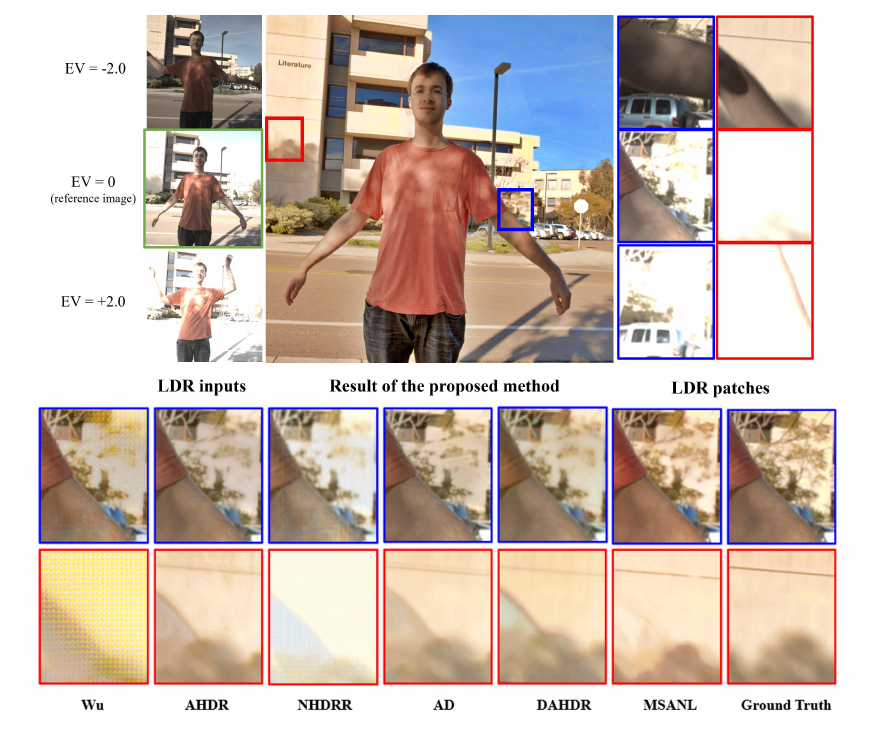
Figure 1. Visual comparison of HDR image restoration results obtained using the proposed method and state-of-the-art methods. From left, Wu [28], AHDR [26], AD [27], NHDRR [30], DAHDR [39], Proposed MSANLnet, and Ground